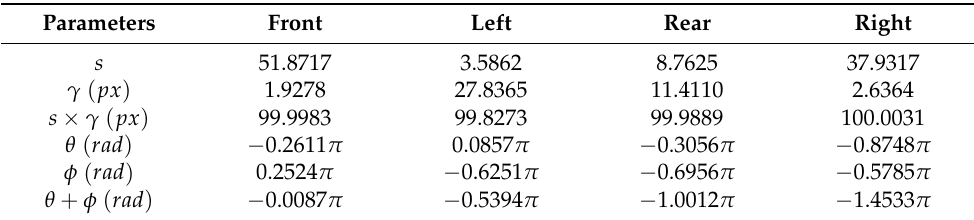
Table 2. The relationship between the normalized coefficients and estimated parameters.